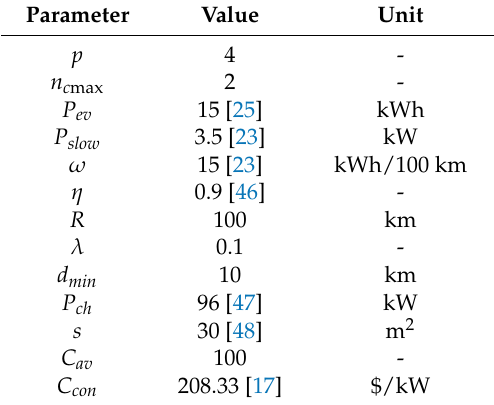
Table 2. The study parameters.